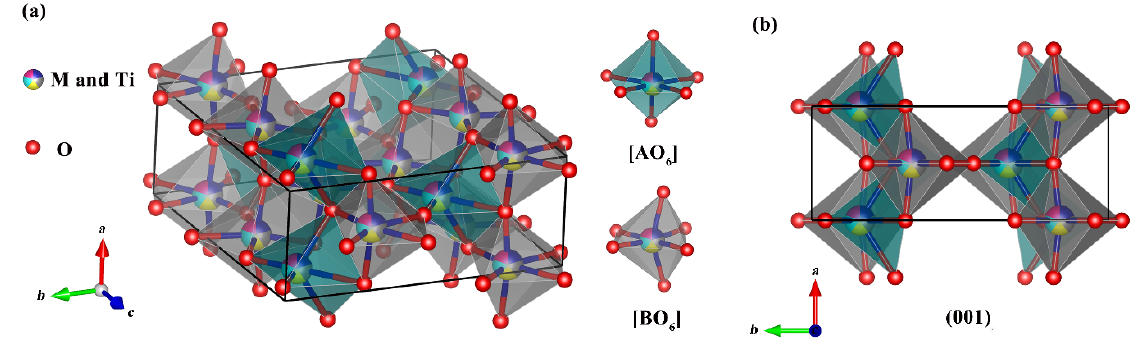
Fig. 1 (a) Ideal crystal structure with the most disordered state of the high-entropy pseudobrookite phase; (b) the (001) crystal plane of the ideal crystal structure of the high-entropy pseudobrookite phase.